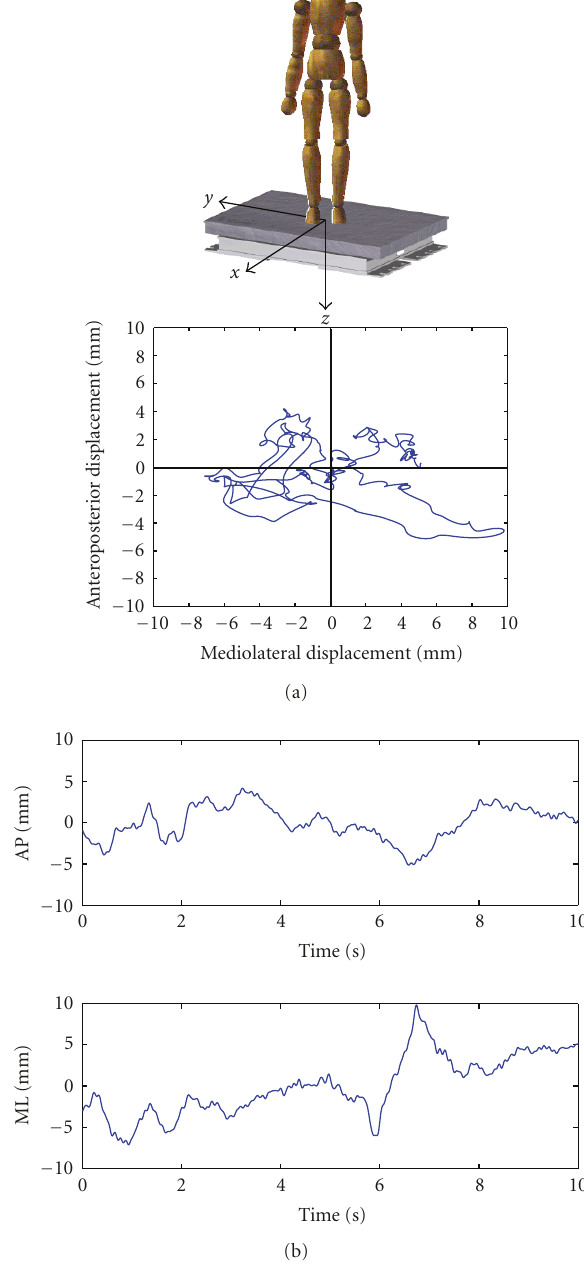
Figure 1: Displacement of the center of pressure in the horizontal plane (bottom left), displacement in the anteroposterior direction over time (top right), and displacement in the mediolateral direction over time (bottom right). Data are recorded from a healthy control subject for 10